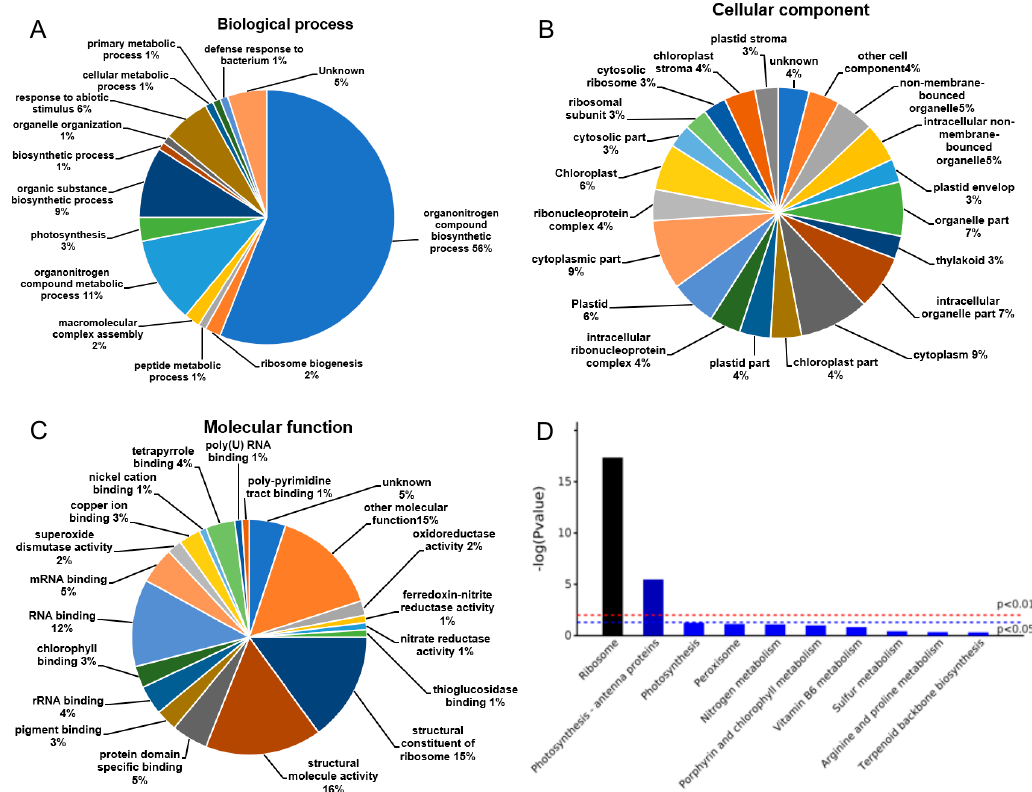
Figure 3. Classification of Gene Ontology (GO) in biological processes ( A ), cellular components ( B ), and molecular functions ( C ) and classification of pathway by the Kyoto Genomics and Genomics Encyclopedia (KEGG) in which the identified proteins involved are shown ( D ).